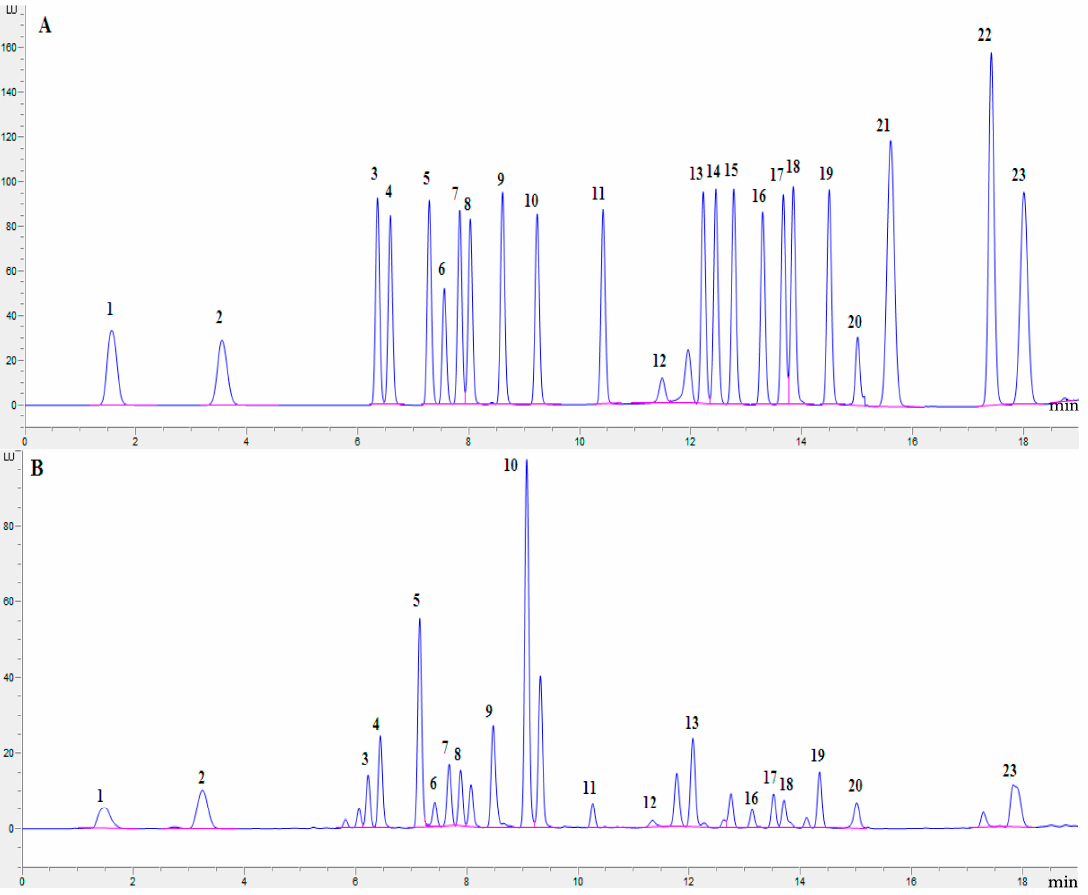
Figure 1. Typical chromatograms of free amino acid analysis by online pre-column derivazation RP-HPLC. ( A ) standard of 23 amino acids; ( B ) Suillus placidus . 1. aspartic acid; 2. glutamic acid; 3. asparagines; 4. serine; 5. glutamine; 6. histidine; 7. glycine; 8. threonine; 9. arginine; 10.alanine; 11. tyrosine; 12. cysteine; 13. valine; 14. methionine; 15. norvaline; 16. tryptophan; 17. phenylalanine; 18. isoleucine; 19. leucine; 20. lysine; 21. hydroxyproline; 22. sarcosine; 23. proline. Essential amino acid (EAA) contents in the analyzed species varied between 154.3 mg/100 g in